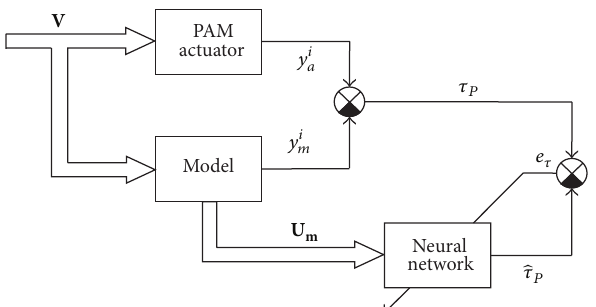
Figure 6: Proposed identification scheme for the estimation of disturbance term 𝜏 𝑃 using a neural network. In the scheme, V is valve control signal vector, 𝑦 𝑖 𝑎 is 𝑖 th actuator output variable, 𝑦 𝑖 𝑚 is ̂𝜏 𝑖 th model output variable, 𝜏 𝑃 is disturbance term, 𝑃 is disturbance term estimation, 𝑒 𝜏 is disturbance term estimation error, and U m is neural network input